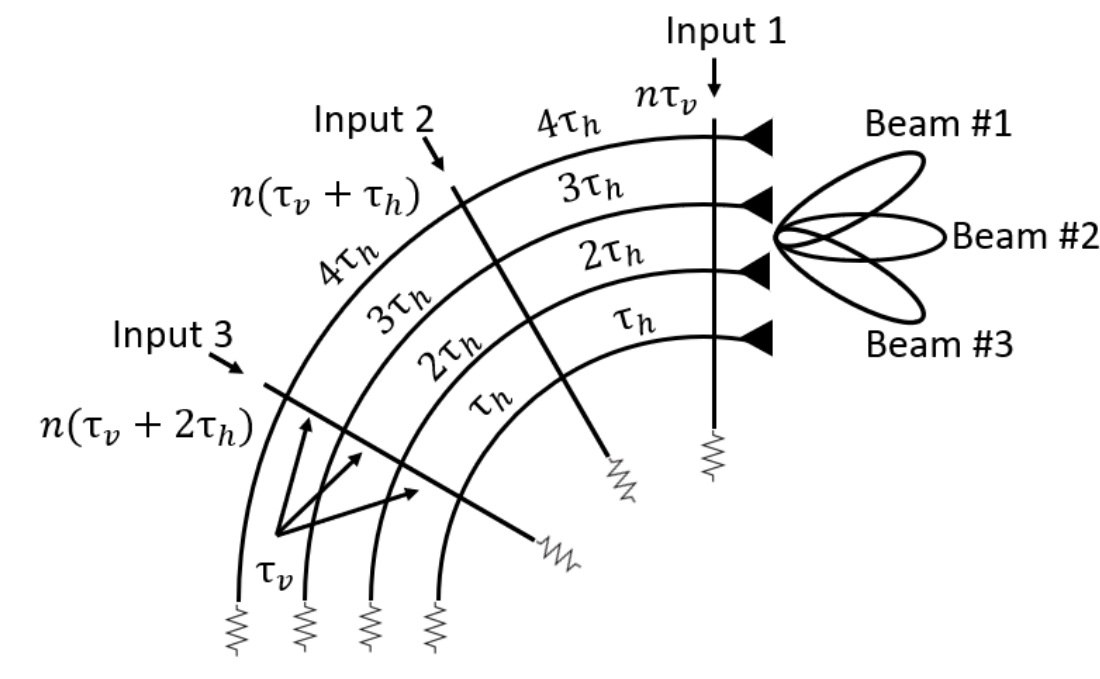
Figure 3. Blass matrix schematic.